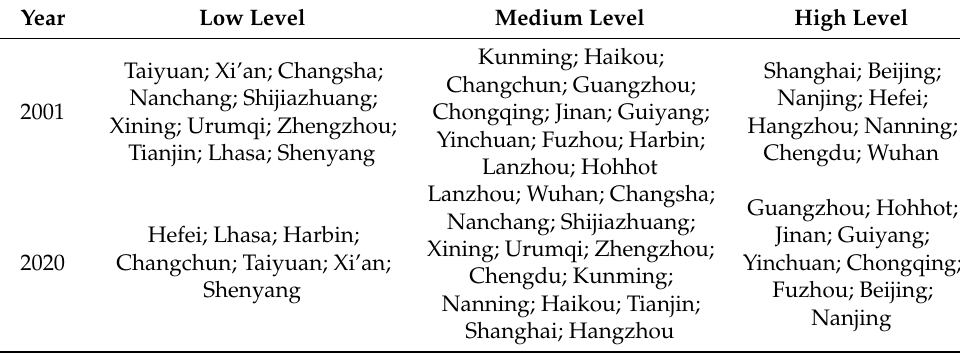
Table 3. Spatial evolution trend of urban green space